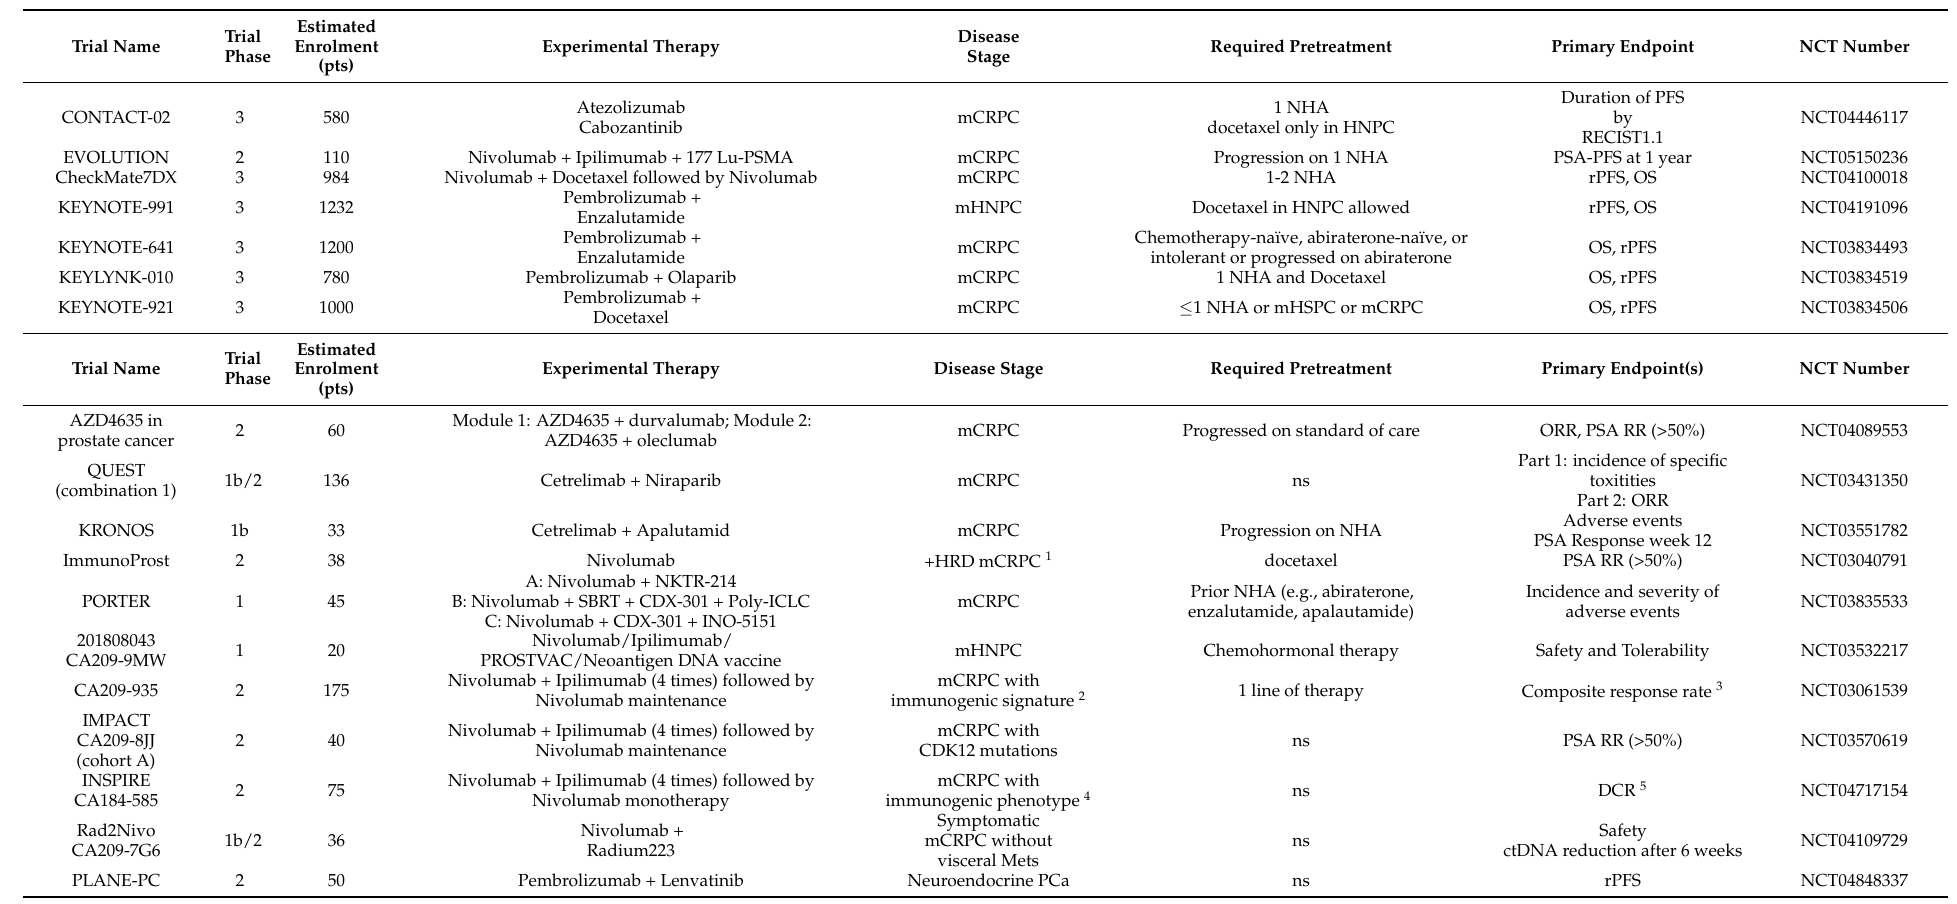
Table 2. Active clinical trials on biomarker-selected patients and combinational treatment approaches with checkpoint inhibitors in advanced prostate